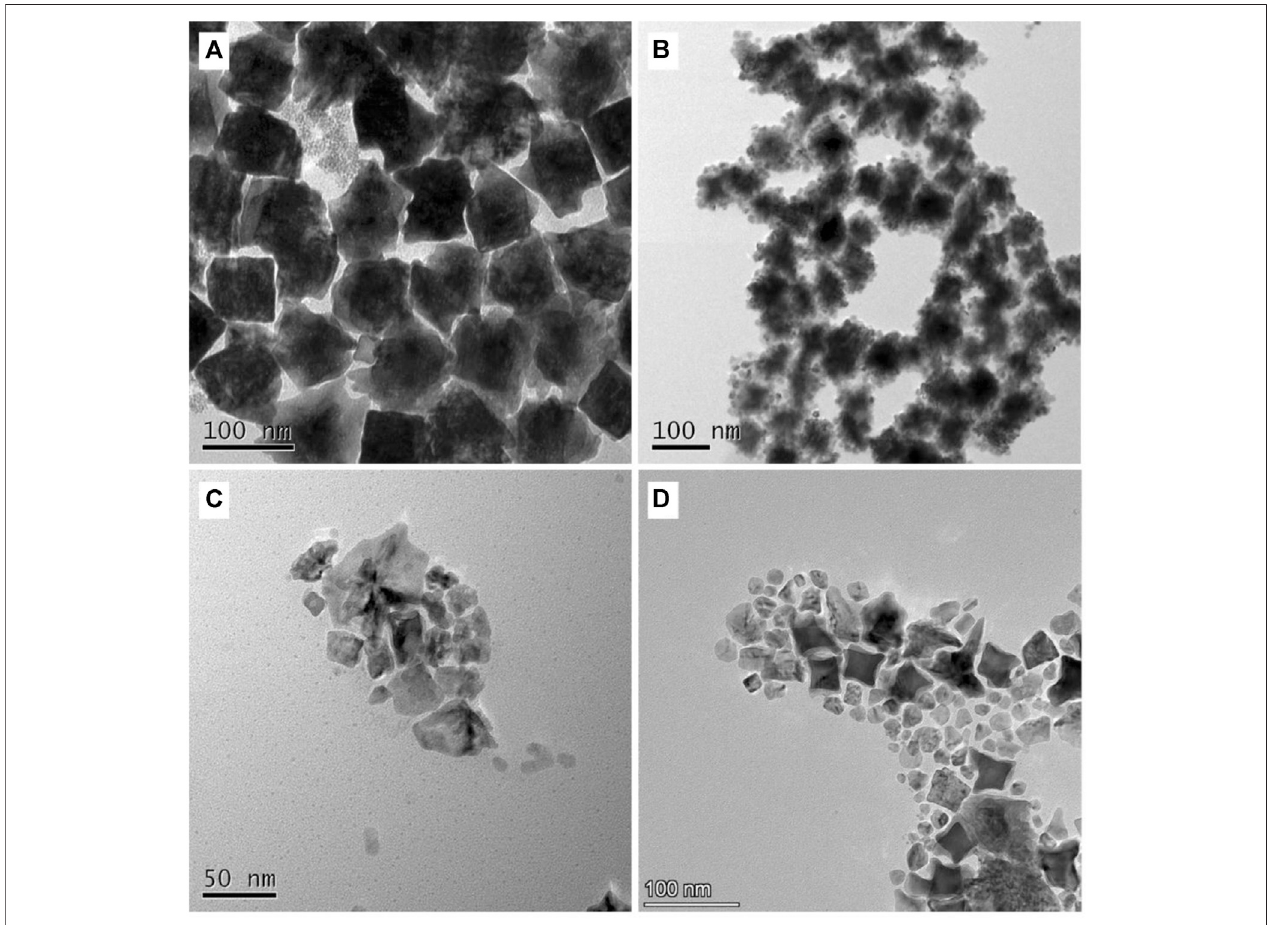
FIGURE 5 | Effect of (A, B) capping effect and (C, D) reaction kinetics over the product morphology and structure. TEM images of products obtained via the synthetic procedure P5, except that (A, B) the capping agent DTAC was replaced by (A) CTAC and (B) CTAB; (C, D) the amount of AA was varied from 5 μ mol to (C) 20 μ mol and (D) 100 μ mol,